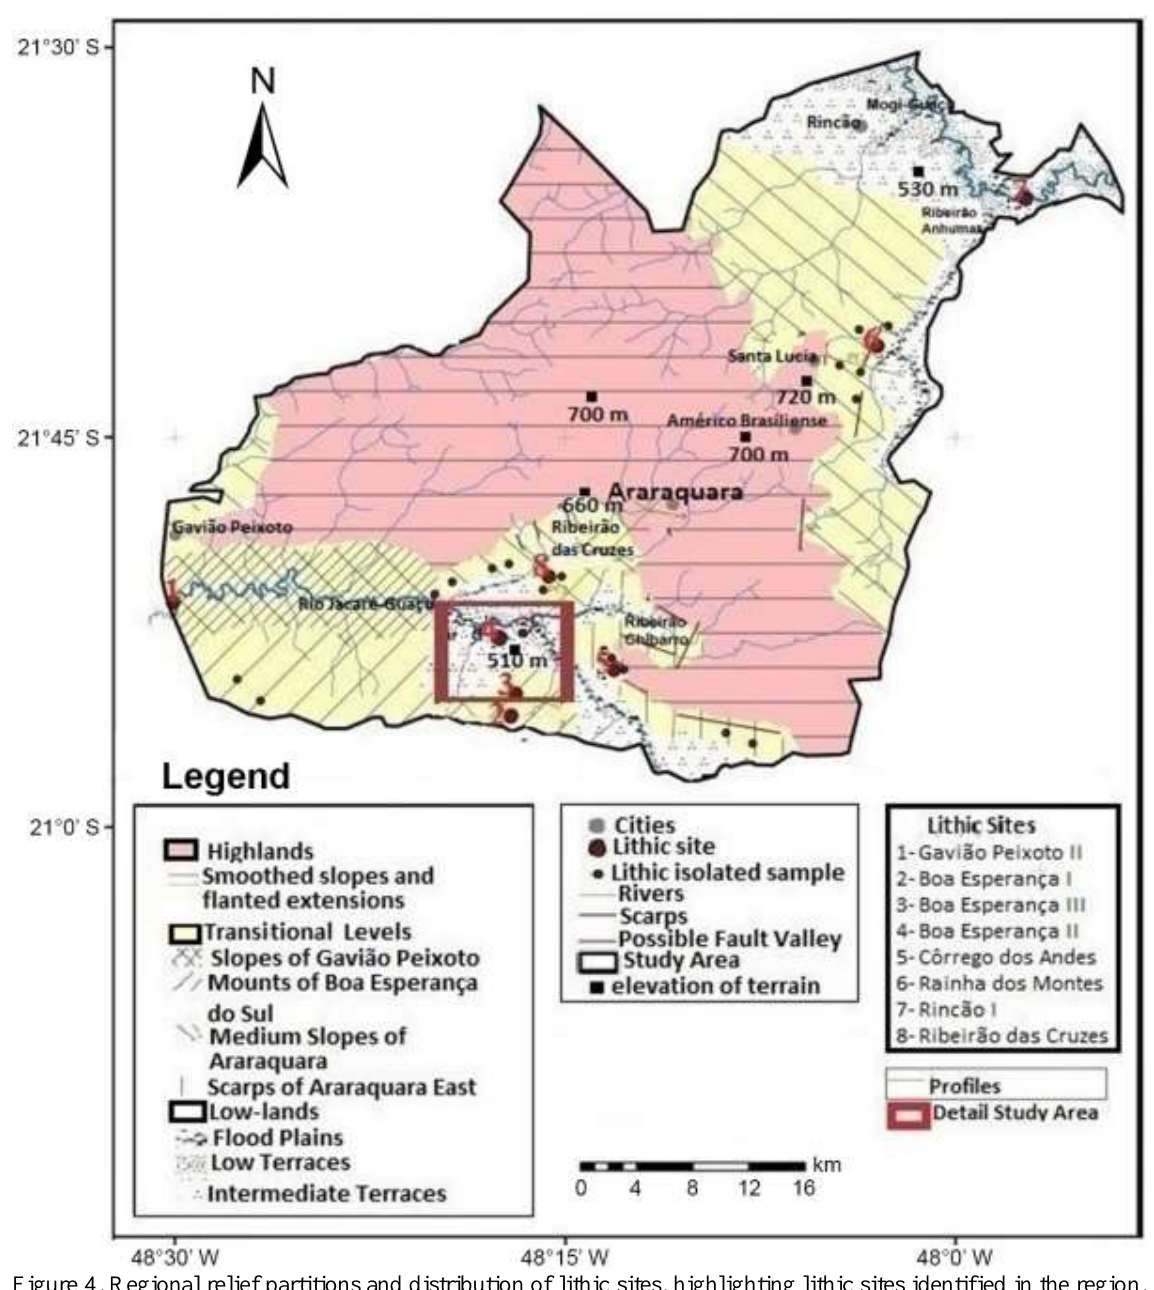
Figure 4. Regional relief partitions and distribution of lithic sites, highlighting lithic sites identified in the region, including BES II. Source: adapted from Cheliz